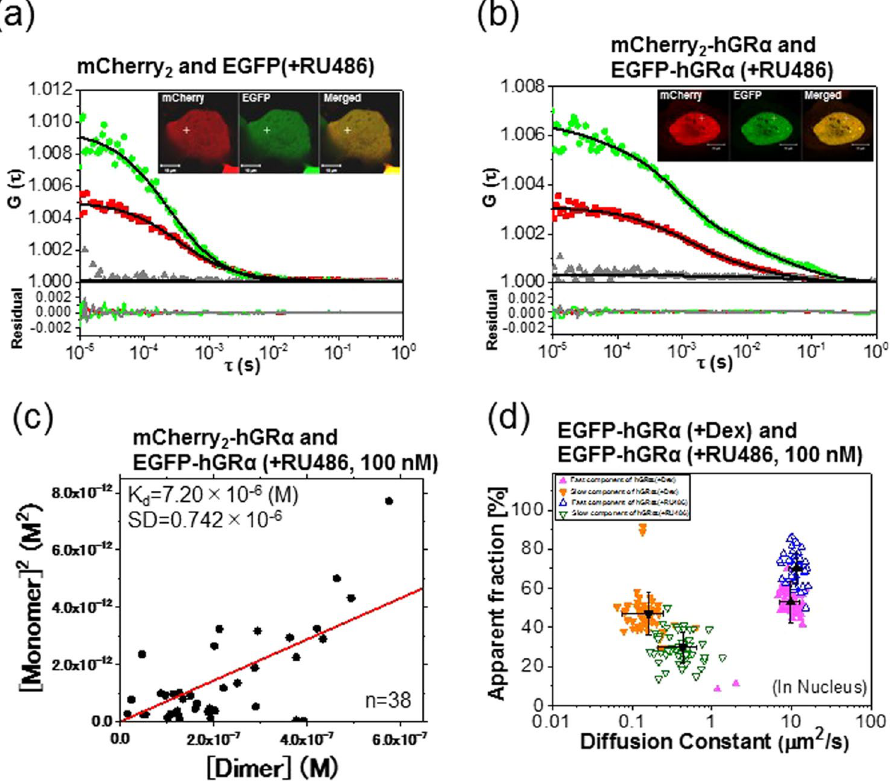
Figure 4. The effect of RU486 on GR α analyzed by FCCS. Typical auto- and cross-correlation curves obtained from U2OS cells coexpressing the pairs of chimeric fusion proteins before and after addition of the ligand. The filled green diamonds, red squares, and gray triangles denote autocorrelation of the green channel [ G G ( τ )], autocorrelation of the red channel [ G R ( τ )], and the cross-correlation curve [ G C ( τ )], respectively, with their fits (solid black lines) and residuals. The insets show LSM images of U2OS cells coexpressing the pairs of chimeric fusion proteins. Measurement positions of FCCS are indicated by the white crosshairs. The scale bars are 10 μ m. FCCS was performed in U2OS cells expressing ( a ) mCherry 2 and EGFP as a negative control, after addition of RU486 and showing a flat cross-correlation amplitude; ( b ) U2OS cells coexpressing mCherry 2 -hGR α and EGFP-hGR α in the nucleus 20 min after addition of 100 nM RU486. ( c ) The K d plot represents the square of the concentrations of the monomeric hGR α versus the concentration of the dimer of hGR α after addition of RU486. The solid line shows the linear fit. ( d ) The scatter plots represent the diffusion constants versus their fractions from fitting analysis of FCCS data with a two-component model. Black symbols indicate the average of the diffusion constants of the fast and slow components. The data are presented as mean ± SD. Fast and slow components are shown with different colors and symbols. EGFP-hGR α after addition of Dex (filled symbols) and RU486 (open